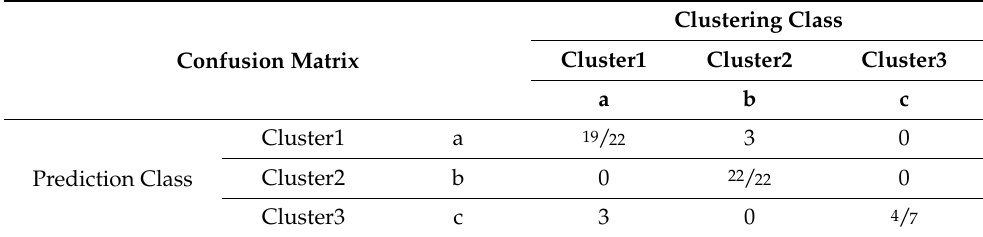
Table 13. Neural network classification validation for Cascade K-means clustering.